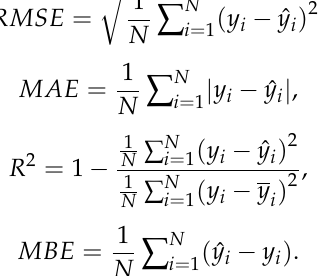
To determine the best values for the weight parameters, the loss function provides the opportunity to specify the appropriate weights. There are different statistical parameters available in the regression context for loss value estimation such as root mean squared error (RMSE), mean absolute error (MAE), and mean bias error (MBE), which specify the goodness of weight parameters. Lower loss values indicate better weight parameters. In and y is the mean value of all y in the range 1 to N . N is the number of sample points. i The R-squared, RMSE, MAE, and MBE parameters are used as metrics of model accuracy (Equations (16) to